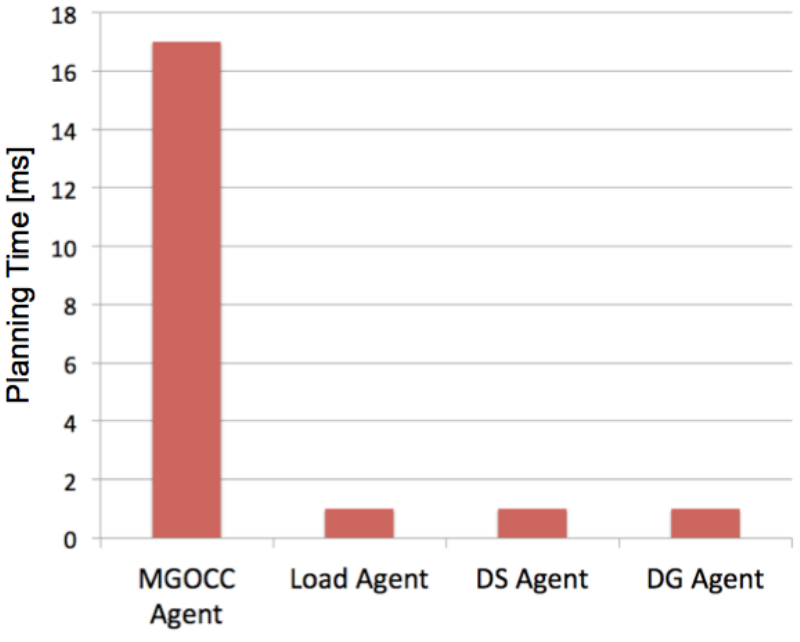
Figure 23. The calculation time of the existing multiagent architecture.